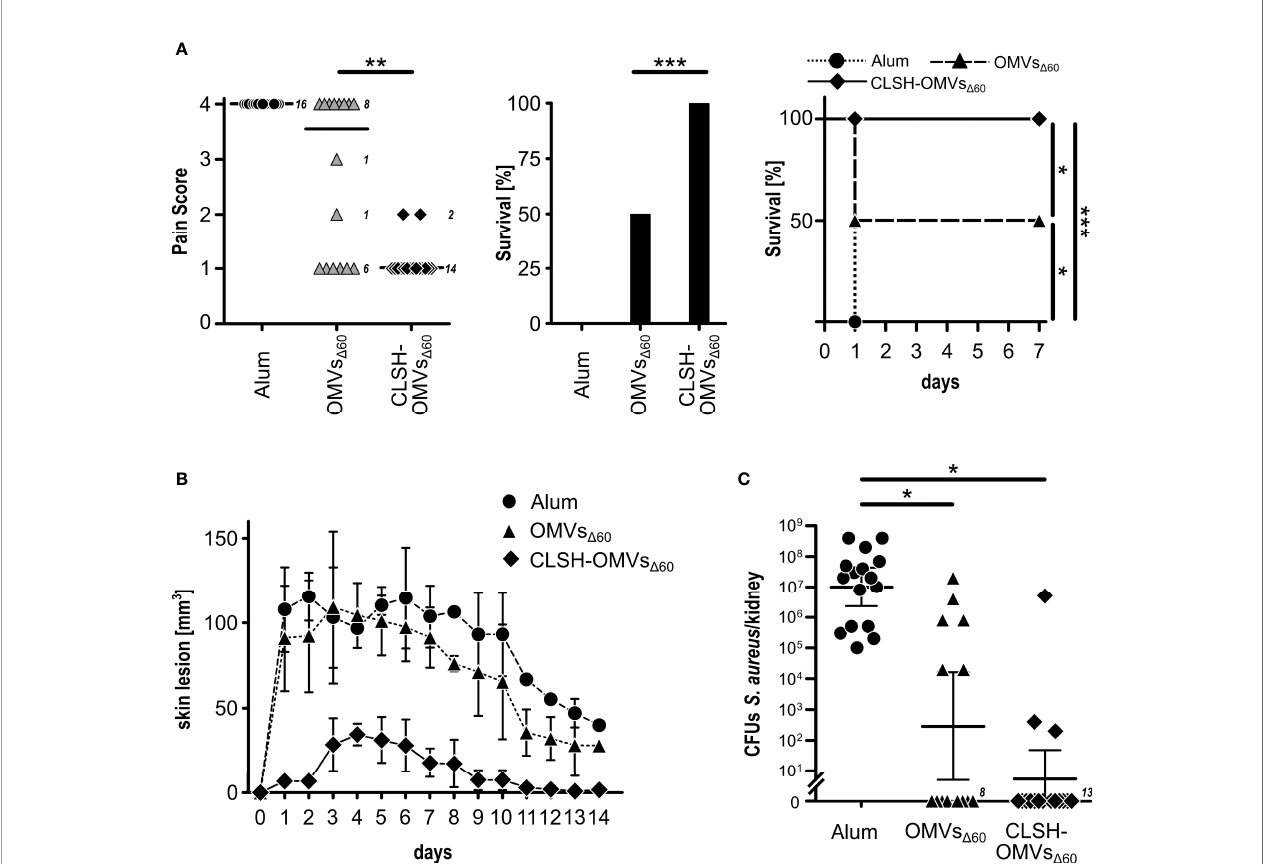
FIGURE 3 | In vivo protective activity of OMVs D 60 expressing S. aureus antigens. (A) Sepsis model . Groups of 16 female CD1 mice were immunized three times at 2-week intervals with Alum alone (circles), “ empty ” OMVs D 60 (triangles) or CLSH-OMVs D 60 (diamonds), formulated in Alum. After 2 weeks, mice were infected i.p. with 3×10 8 CFUs of S. aureus Newman strain. Animal health was monitored over a period of 7 days, assigning a “ pain score ” from 1 to 4. Animals which reached a pain score = 4 were sacri fi ced. The three graphs show the pain score (left), survival at day 7 (center) and the survival over time (Kaplan-Meier curve) (right). See text for de fi nition of “ survival ” . Statistical analysis for the pain score plot was performed using Mann-Whitney test. Median is shown. **P = 0.0015. Statistical analysis for the Kaplan – Meier plot was performed using the log rank test. *P = 0.0253; ***P = 0.0001. (B) Skin model . Groups of 16 CD1 female mice were immunized three times at 2-week intervals with Alum alone (circles), “ empty ” OMVs D 60 (triangles) and CLSH-OMVs D 60 (diamonds). At day 14 after the third immunization, mice were s.c. infected with 5×10 7 CFUs of S. aureus Newman strain. Abscess size was monitored once a day for 14 days. Mean ± s. d. is shown. Skin abscess areas of vaccinated and control animals were tested for signi fi cance by means of repeated ANOVA measures using the R base function aov() . (C) Renal abscess model . Groups of 16 CD1 female mice were immunized three times at 2-week intervals with Alum alone (circles), “ empty ” OMVs D 60 (triangles) and CLSH-OMVs D 60 (diamonds). Ten days after the last immunization, mice were infected i.v. with a sub-lethal dose of S. aureus Newman strain (1×10 7 CFUs) and 4 days afterward, mice were sacri fi ced, kidneys collected and homogenized in PBS, and aliquots were plated on agar media for CFUs determination. Statistical analysis was performed using two-tailed Student ’ s t-test. Geometric mean ± 95% con fi dence interval is shown. *P <